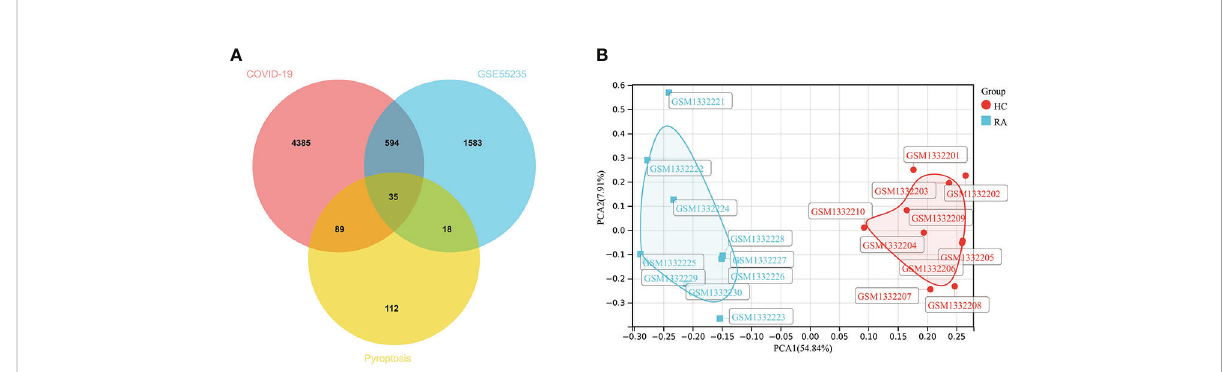
FIGURE 4 Screening Co-genes. (A) Venn-diagram on COVID-19, RA-DEGs (GSE55235), pyroptosis-related genes. Co-genes include 35 genes. (B) PCA analysis of Co-genes in the GSE55235 dataset: PC1 (54.84%) and PC2 (7.91%).